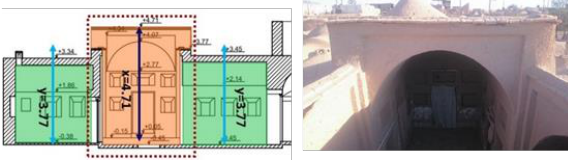
Figure 16. South Side higher than other sides in the Shariari’s home.